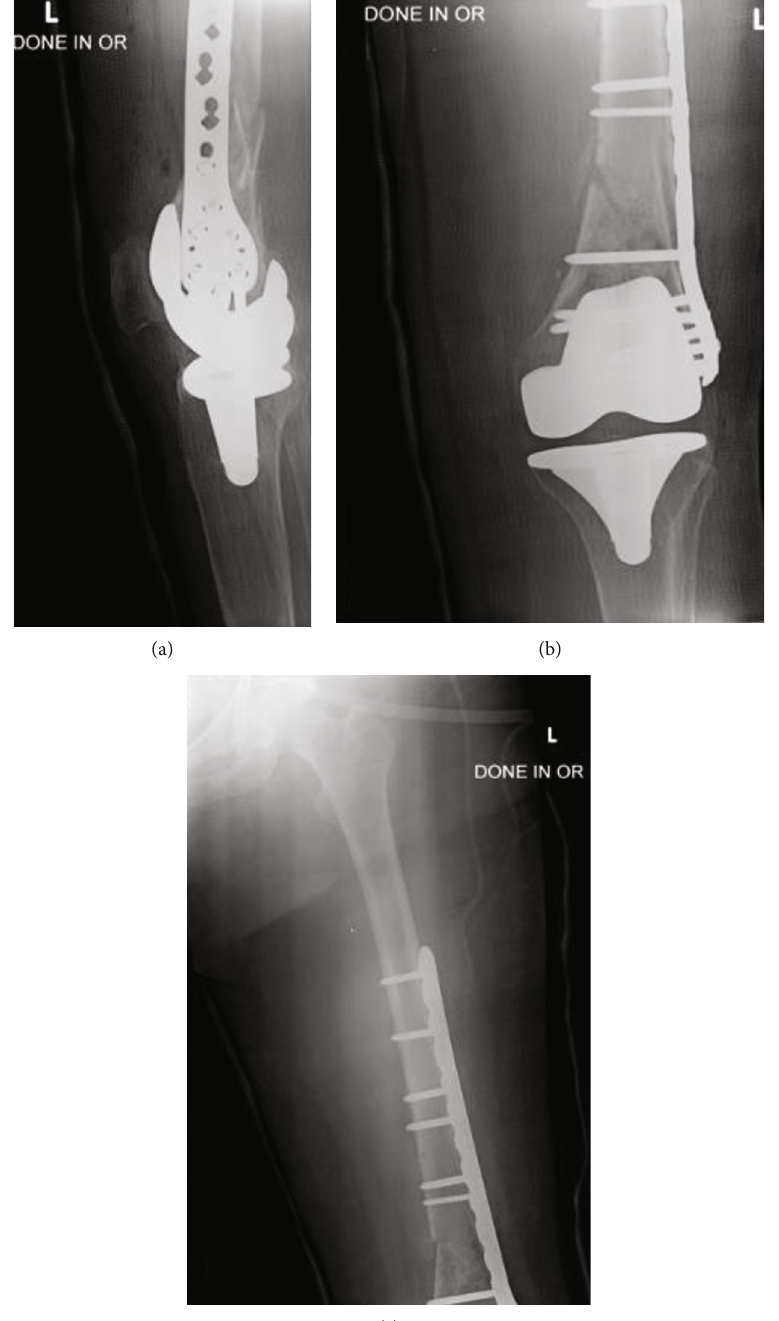
Figure 2: Postoperative lateral (a) and A-P (b, c) radiographs done in the OR, showing reduction of fracture status post management with ORIF and lateral plate-and-screw fi